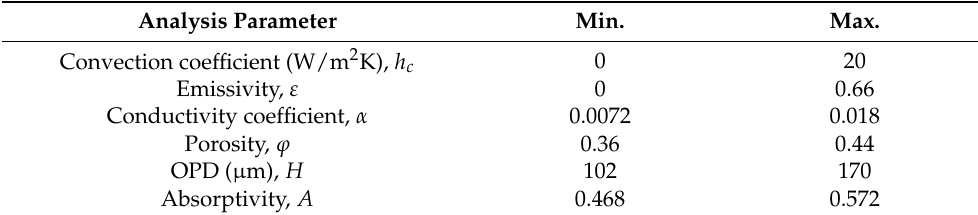
Table 3. Range of analysis parameter.